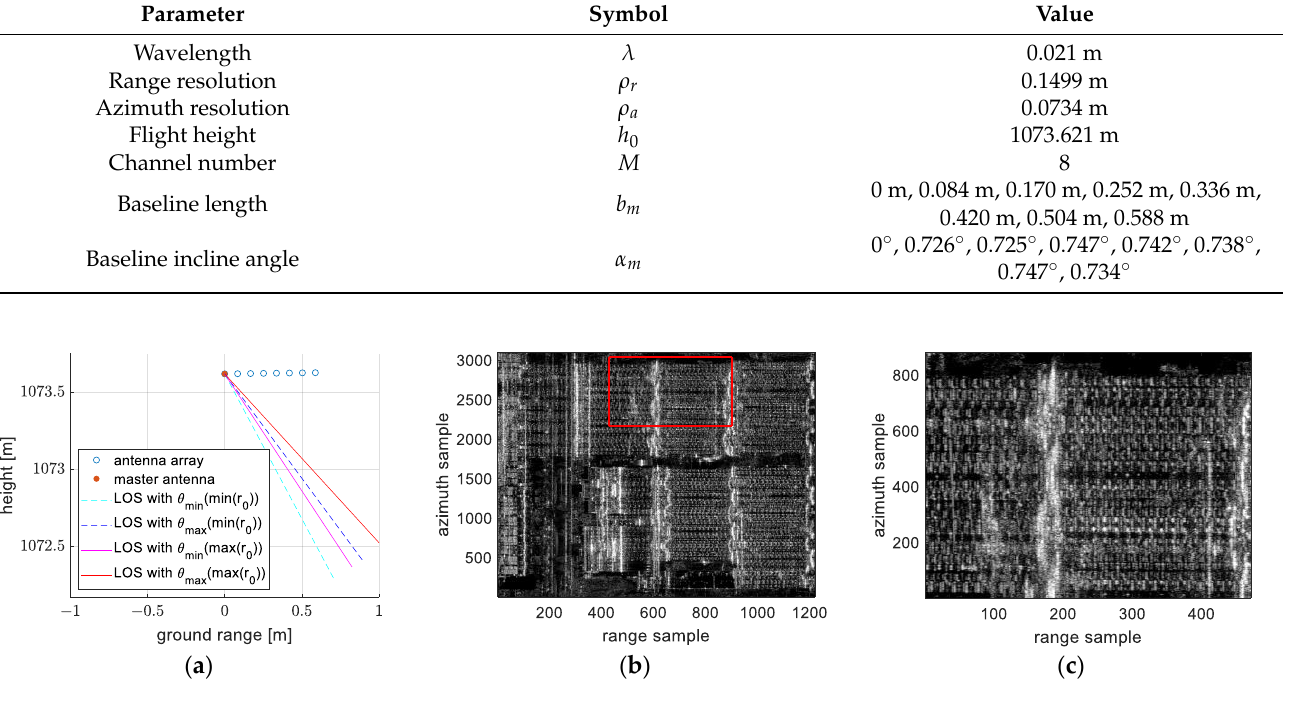
Table 5. System parameters of the measured data.